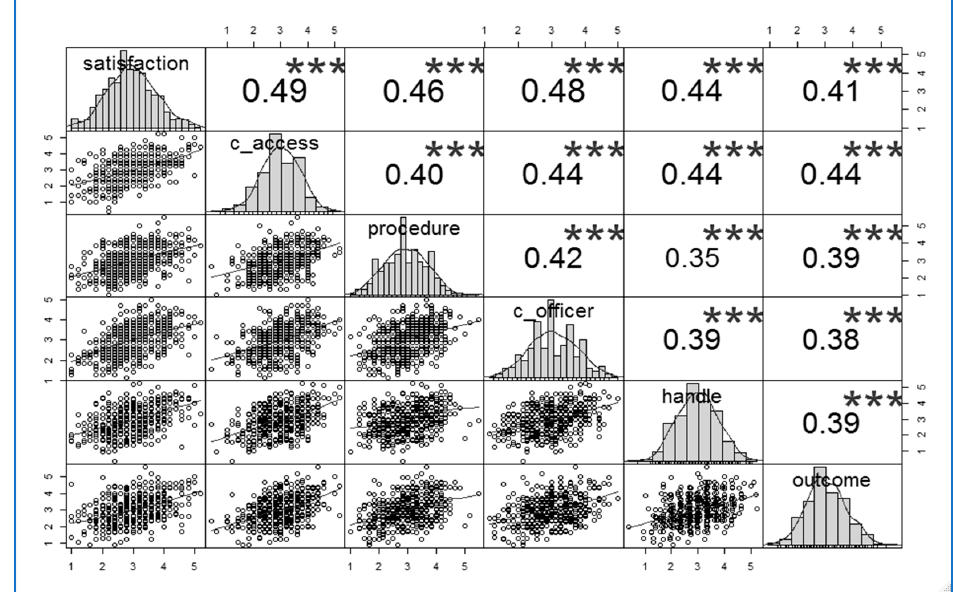
Figure 2. Pearson correlation analysis results. Note: *** p < 0.01.